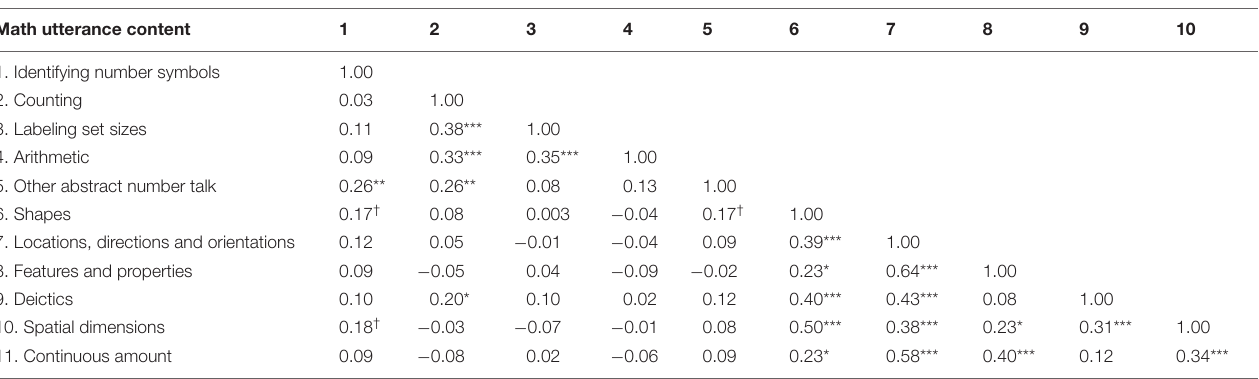
TABLE 6 | Pair-wise correlations among number and spatial utterance content codes. Math utterance